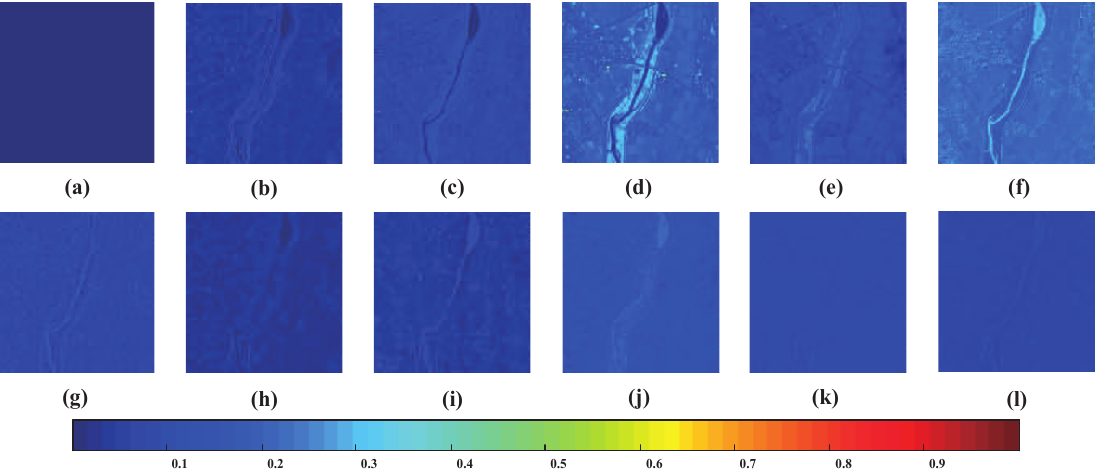
Figure 12. Absolute difference maps between the pansharpened results and the reference one obtained by different methods on the Chikusei data set: ( a ) reference, ( b ) SFIM, ( c ) MTF-GLP, ( d )